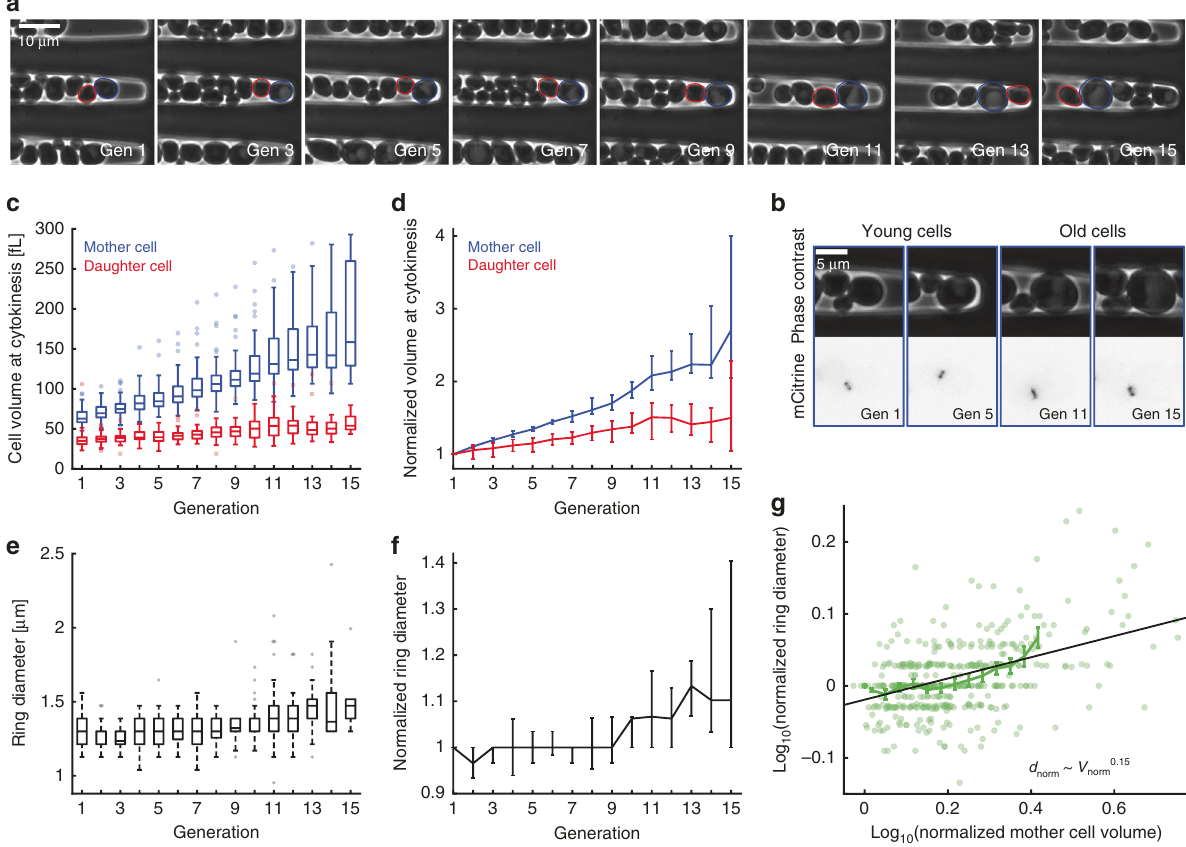
Fig. 4 Septin ring diameter increases with age-dependent mother cell volume. a Newborn cells trapped in a cavity were imaged for multiple generations. Phase contrast images are shown for a representative mother cell at the time points of cytokinesis from fi rst to fi fteenth division. Mother and daughter segmentations are shown in blue and red, generation numbers are denoted in the images. b Zooms of phase contrast (top) and mCitrine fl uorescence (bottom) images corresponding to the aging cell shown in a are shown for time points where the septin ring is visible. c Mother and daughter cell volumes at the time point of cytokinesis are shown as a function of generation number. d Cell volumes normalized on the volume at the fi rst division are shown as a function of generation number. e Median septin ring diameter during the time when the ring is detected based on Cdc10-mCitrine fl uorescence is shown as a function of generation number. f Septin ring diameter normalized on the diameter during the fi rst bud event is shown as a function of generation number. g For each cell, the normalized ring diameter is shown as a function of the corresponding normalized mother cell volume. A linear fi t to the double- logarithmic data as well as binned means with standard error is shown. Boxplots in c , e show medians and 25 and 75 percentiles. Whiskers denote extreme values still within 1.5 interquartile ranges, symbols denote outliers. Error bars in d , f denote 95% con fi dence intervals as determined from 50,000 bootstrap samples. Cells were grown on SCD. Data are based on 44 cells from four independent experiments tracked over at least nine generations. Source data are provided as a Source Data fi